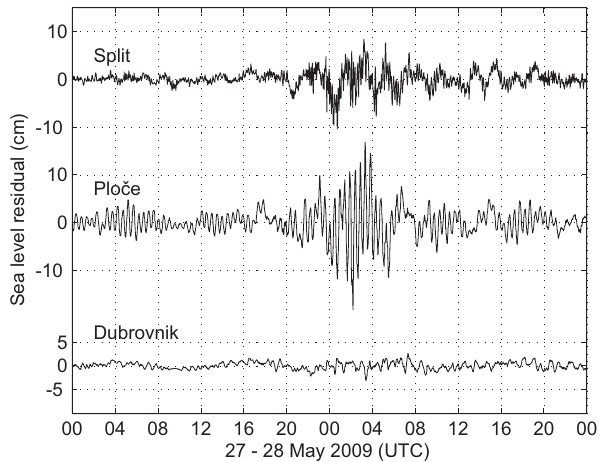
Fig. 5. Sea level time series for Split, Ploˇce and Dubrovnik. Series have been filtered with a 3-h Keiser-Bessel